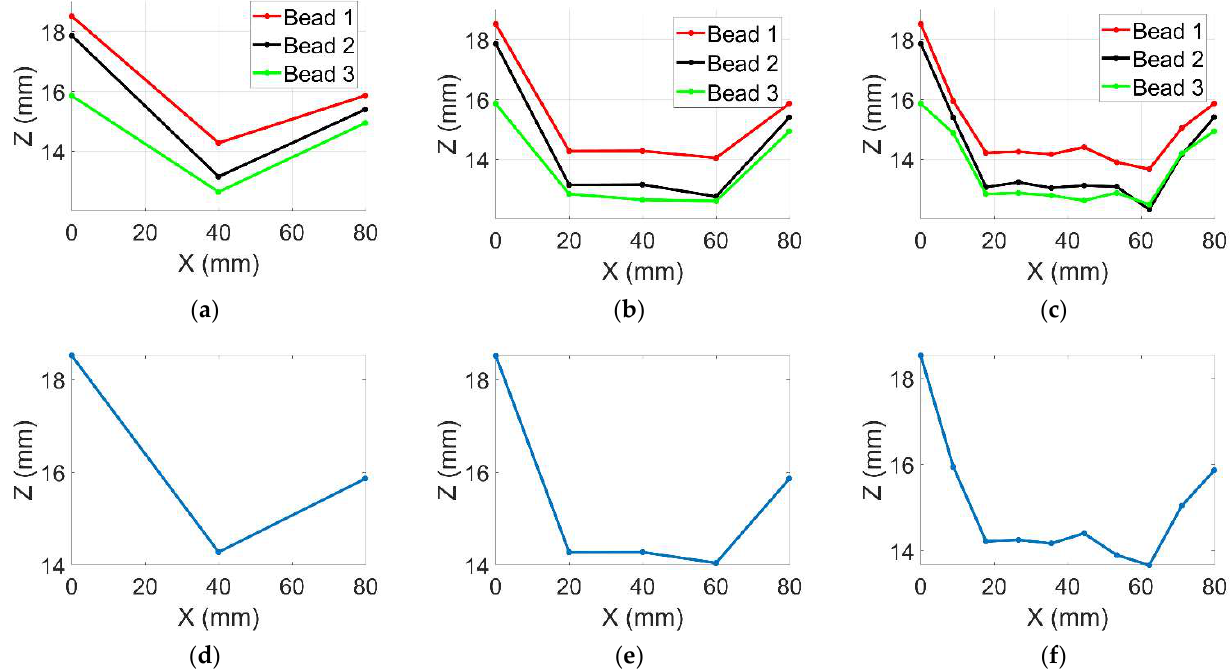
Figure 4. Raw probe data for each bead: ( a ) 3 pt probing; ( b ) 5 pt probing; ( c ) 10 pt probing; consolidated height profiles: ( d ) 3 pt probing; ( e ) 5 pt probing; ( f ) 10 pt probing.